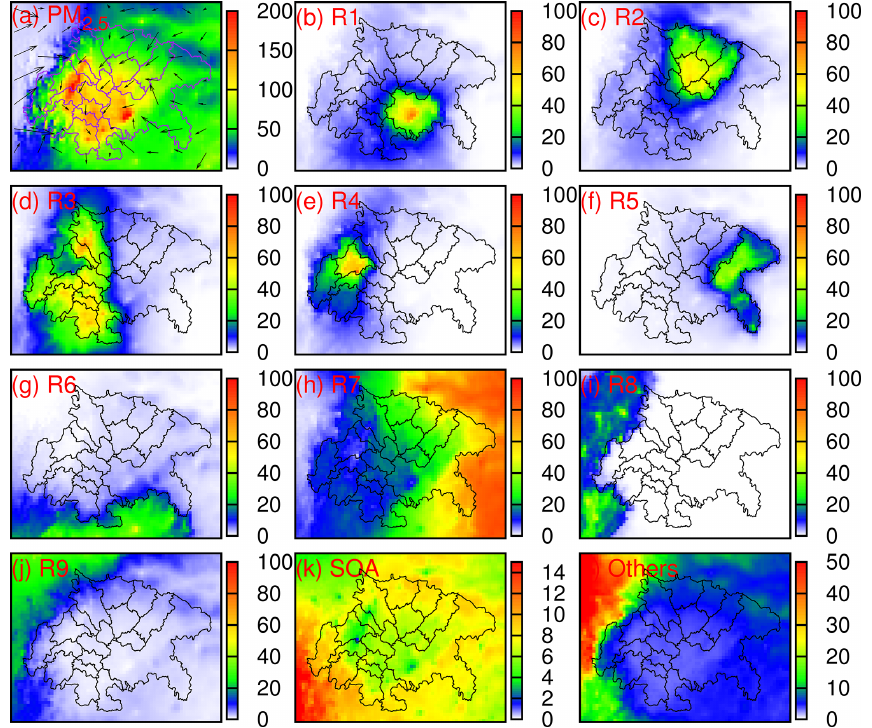
Figure 2. (a) Spatial distributions of predicted PM 2 . 5 concentrations (µgm − 3 ) and (b–l) source-region contributions to PM 2 . 5 (%) in the winter. Others includes IC, BC, windblown dust, and sea salt. Black arrows in (a) are wind